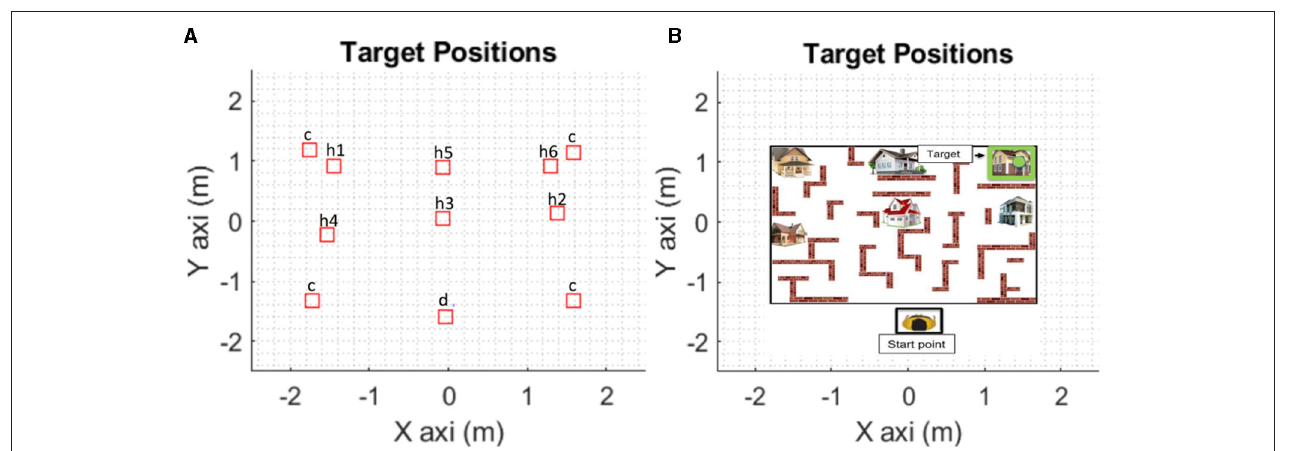
FIGURE 3 | The global navigational array in the X and Y- axis coordinates. (A) The “c” represents de corners, the “h1”, “h2”, “h3”, etc. represent the house order presented to the participant and the “d” represents de Start point. (B) Representation of the projection on the floor including the houses and the start point.